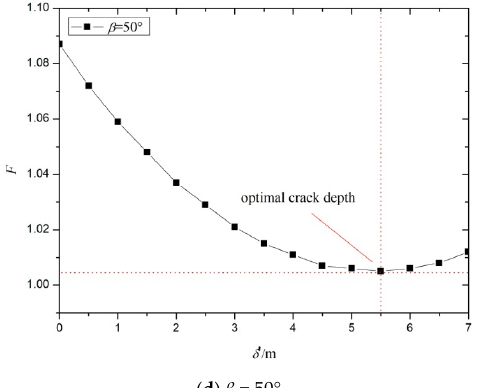
Figure 8. Relationship between safety factor and crack depth under different slope angle.